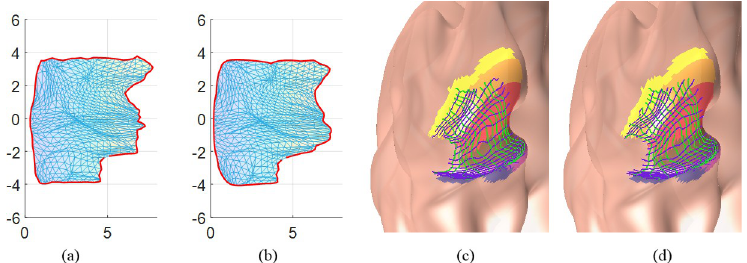
Fig 13. Comparison of two boundary approaches. (A) The result of fixed boundary visual coordinates. (B) The result of changeable boundary visual coordinates. (C) Result of (A) on the inflated cortex. (D) Result of (B) on the inflate